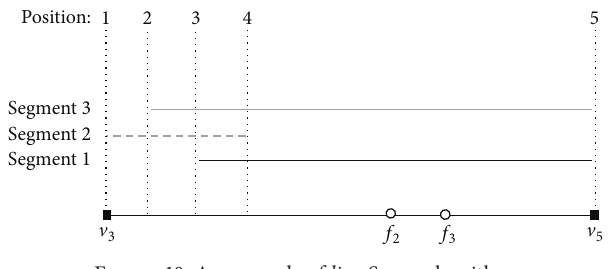
Figure 10: An example of line Sweep algorithm.